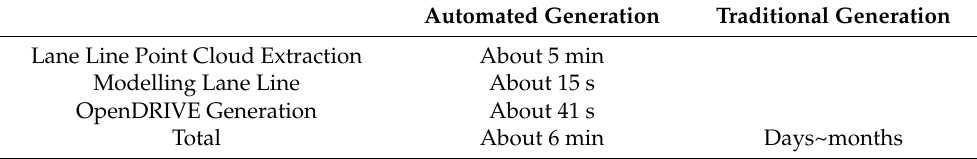
Table 6. Time consumption of each phase of OpenDRIVE